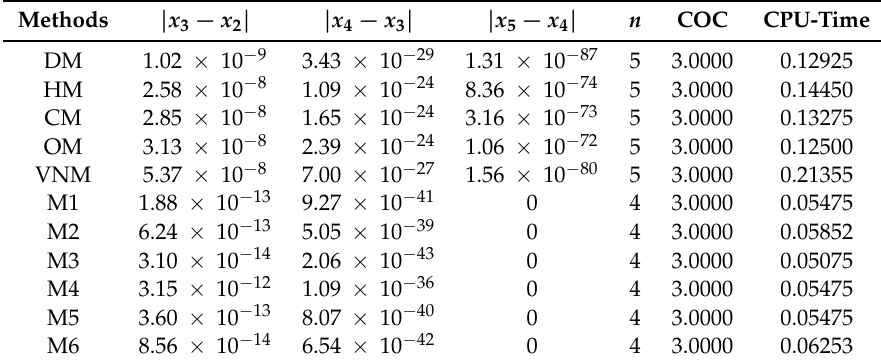
Table 3. Comparison of performance of methods for Example